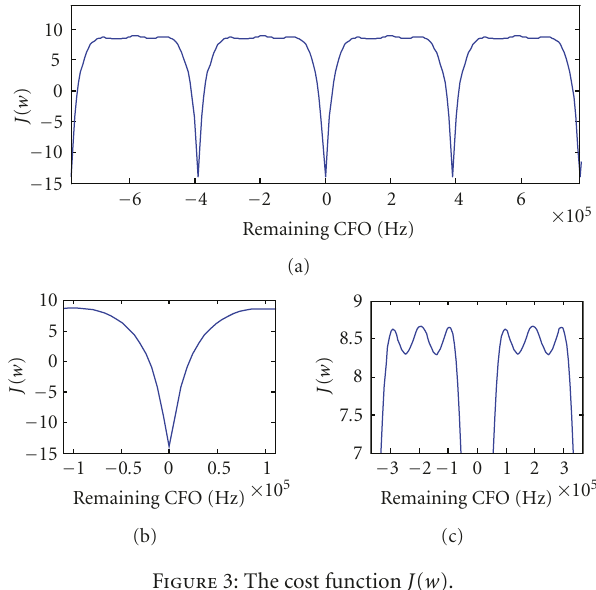
Figure 3: The cost function J ( w